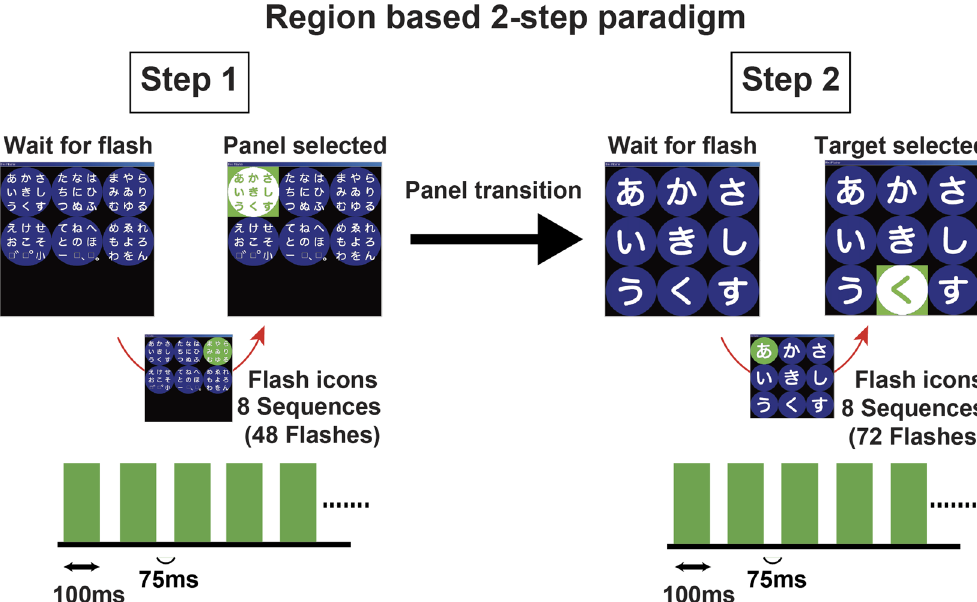
Figure 1. A region-based two-step P300-based hiragana speller. The subject was required to count the number of intensifications of the green/blue circle containing the target character to be input. Each circle flashed eight times, and the interval between two flashes was 175 ms, consisting of 100 ms of intensification (green) and 75 ms of rest (blue). We divided the 6 × 9 matrix into six circled regions including nine characters each. First, each region was intensified individually. When a region that included a target character was selected, the speller matrix moved to the second step. The second step used 3 × 3 regions with one character each, and each region was again